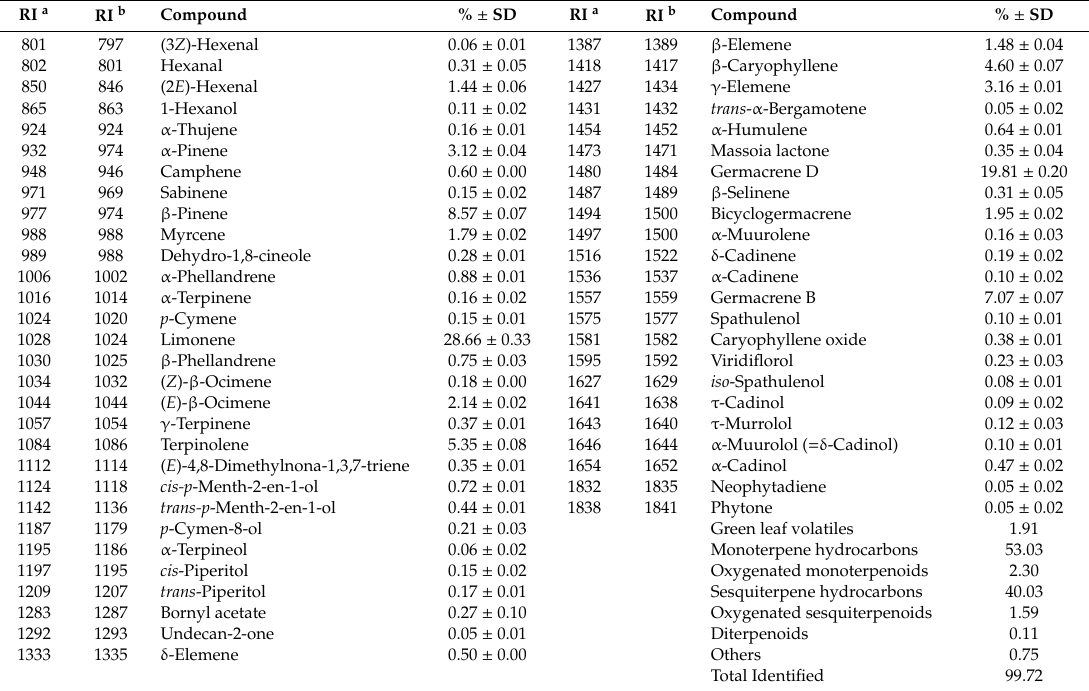
Table 3. Chemical composition of the essential oil of Eurybia macrophylla (L.) Cass.